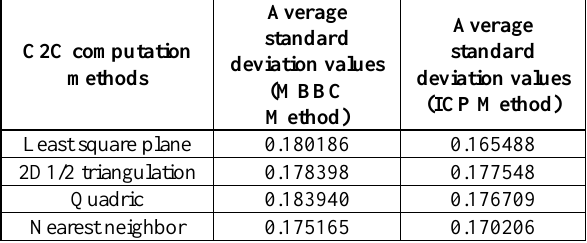
Table 10. The average C2C distance computation standard deviation values between MBBC and ICP methods